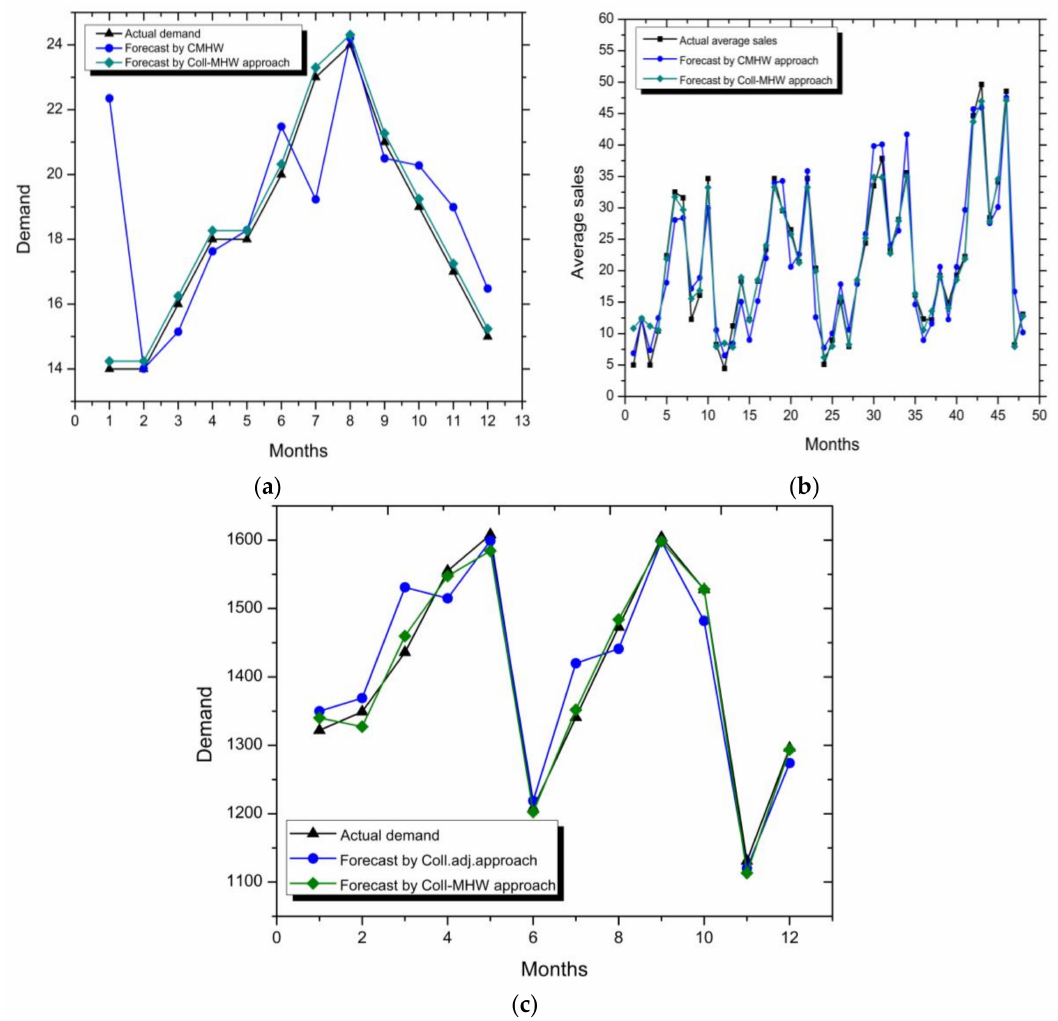
Figure 11. Actual and forecasted values for ( a ) Case-1 ( b ) Case-2 ( c ) Case-3.